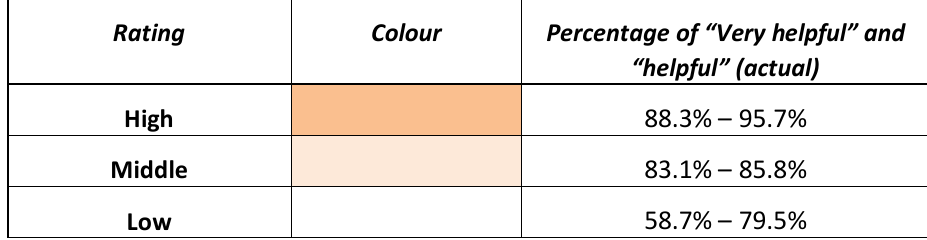
Table 20.1 : Scheme for the evaluated helpfulness of portal support for searching and accessing data items within datasets integrated from multiple sources (“item - level